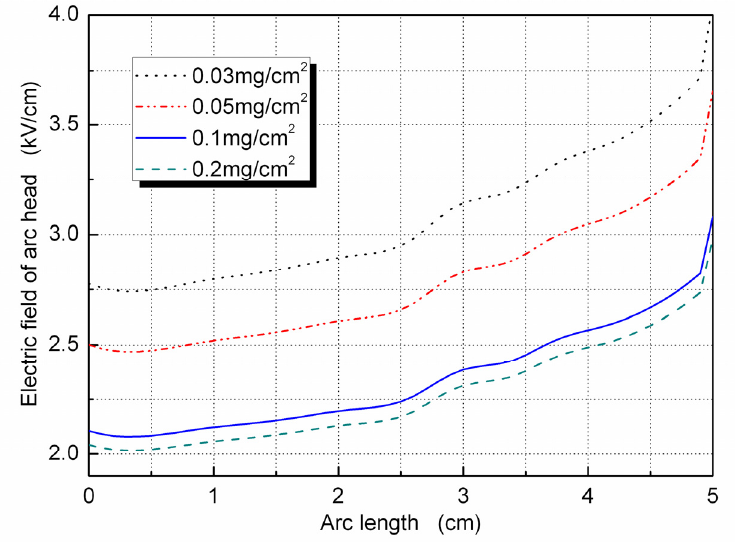
Figure 5. Variation of the electric field of the arc head with the arc length.